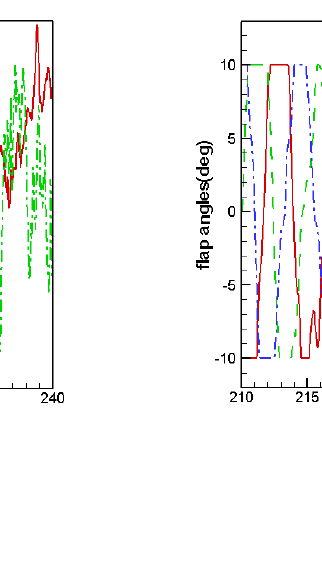
; ( d ) blade y 1 ; ( e ) PSD of M ; ( f ) PSD of B Td 1 y 1 Td 1